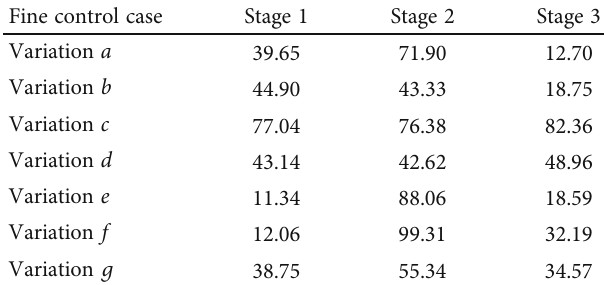
Table 1: Fine control